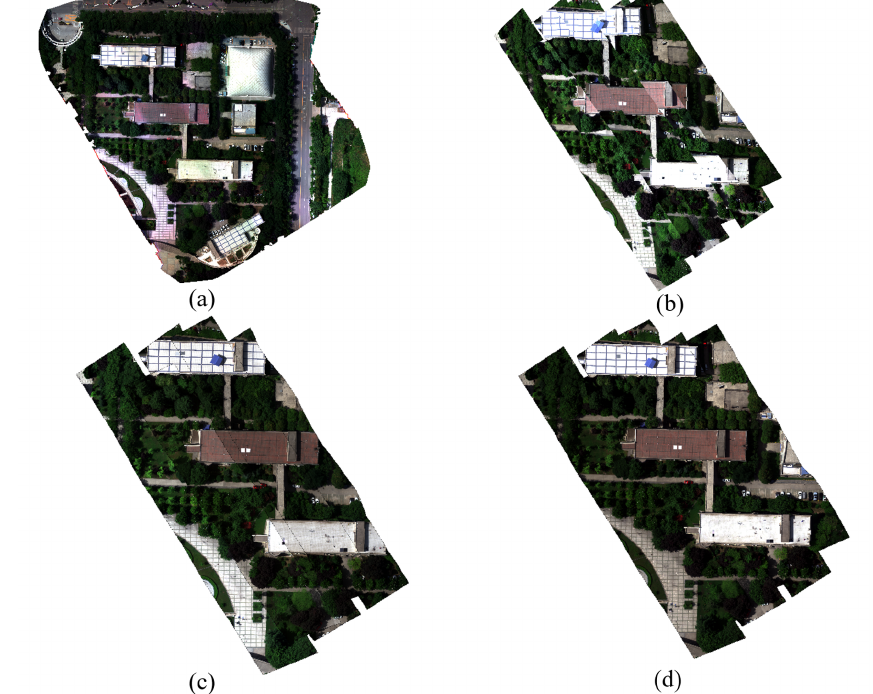
Figure 12. ( a ) Mosaic results of MSI; ( b ) HSI images with geometric correction; ( c ) HSI images of ( b ) registered with MSI; and ( d ) Mosaic result of